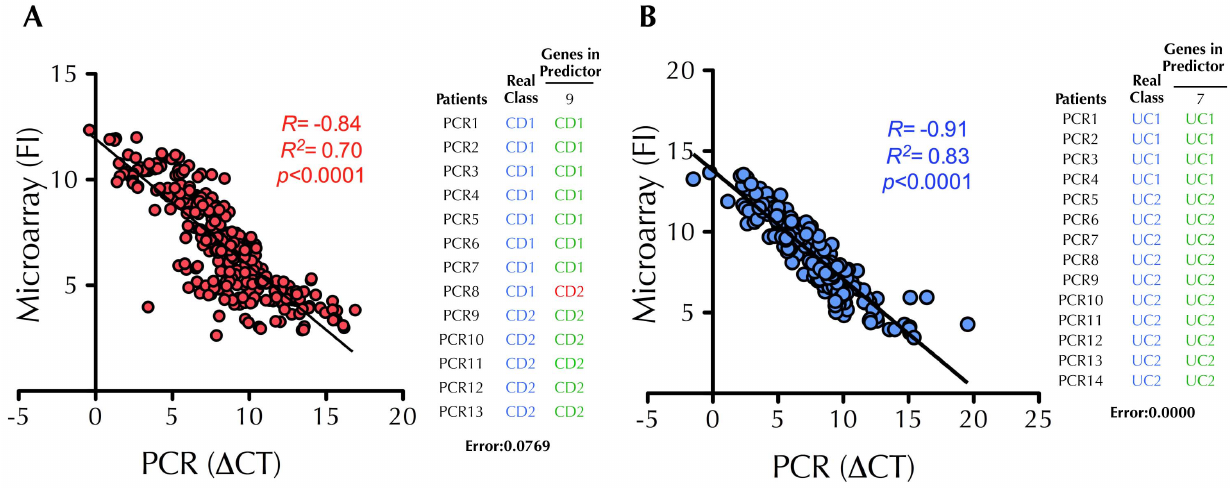
Figure 3. Confirmation of the predictive classifiers of ‘‘High’’ and ‘‘low’’ inflammation subtypes of Crohn’s disease (CD) and ulcerative colitis (UC) by quantitative real time-PCR. A total of 43 genes (including the predictors) were selected for real time-PCR validation of the microarray data in CD (A) and UC (B). Scatter plots show the correlation between microarray (fluorescence intensity, FI) and PCR (DCt value respect to the endogenous GAPDH, DCt) data, validating microarray results. The tables show the predictions obtained with the selected set of genes obtained from the microarray analysis using the PCR data. For each predictor, patients that were correctly classified are shown in green while those patients where the predictors failed to classify are shown in red. The classification accuracy obtained with PCR data was the same as the one obtained with the microarray data.